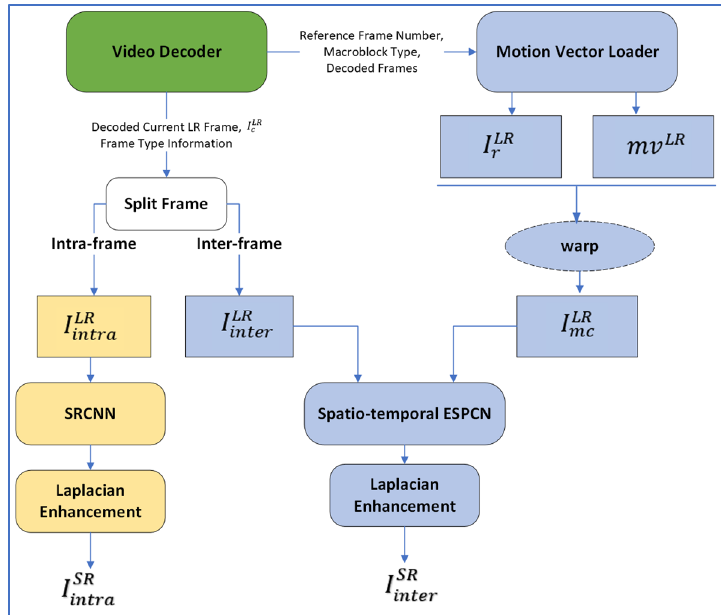
Figure 4. Overview of CILVSR network.